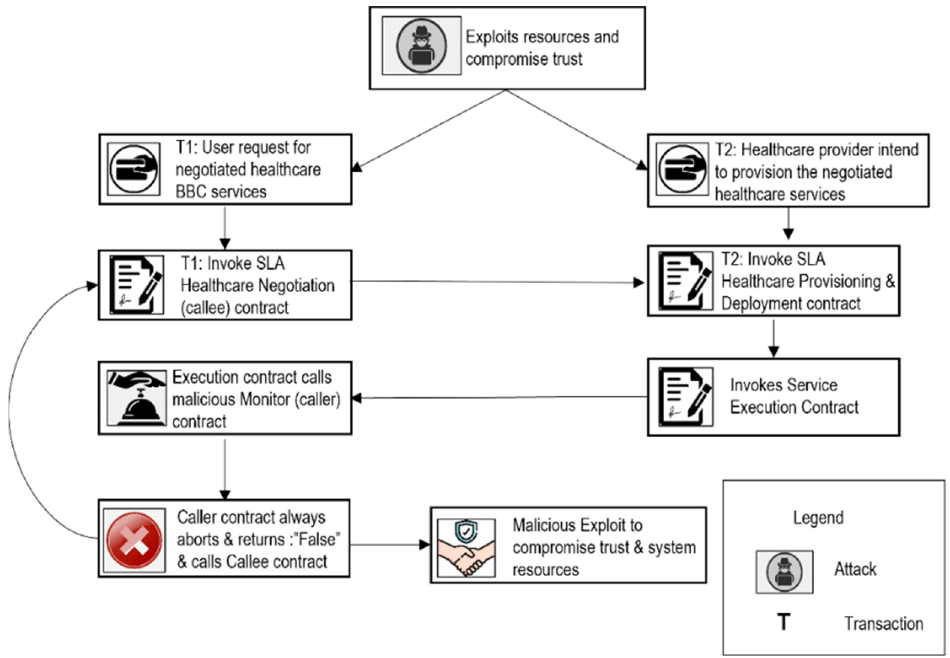
Figure 10. Threat model for reentrancy vulnerability scenario 4: compromised trust and system re-